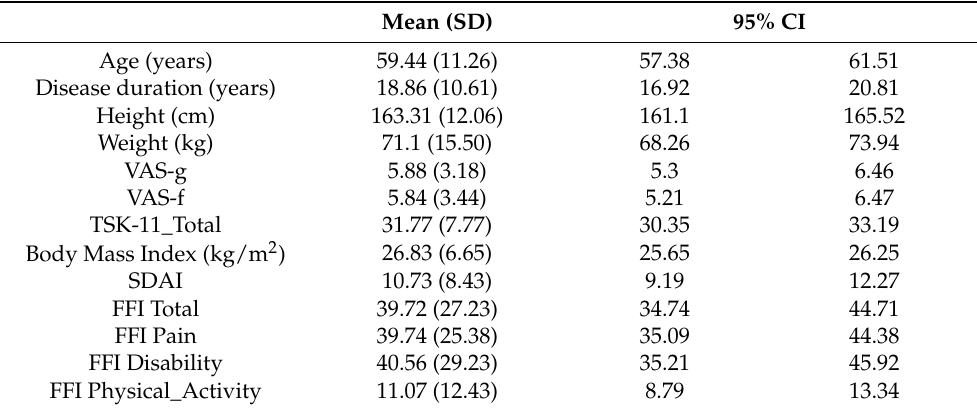
Table 1. Characteristics of the sample reported as the mean and standard deviation (SD) and confidence interval.